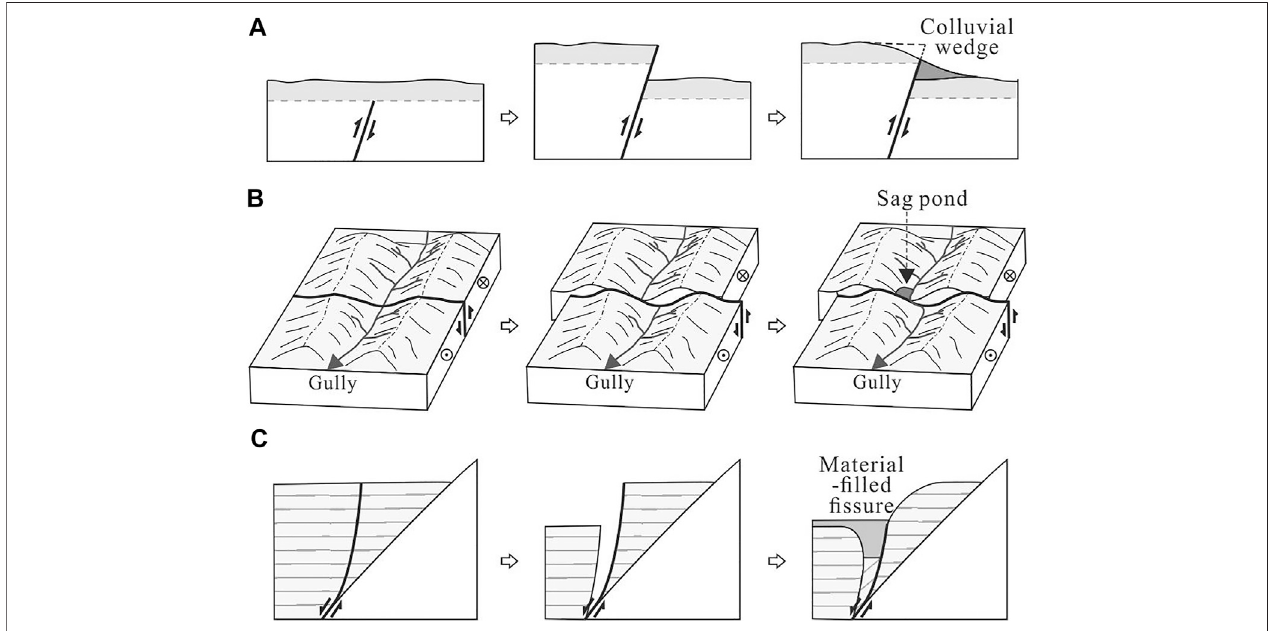
FIGURE 3 | High-quality event indicators and their formation: (A) colluvial wedge, (B) sag pond sediment, and (C) material- fi lled fi ssure, modi fi ed from (Wallace, 1977; Sieh, 1978; Allen et al., 1991; Bonilla and Lienkaemper, 1991; Nelson, 1992; Fumal et al., 1993; McCalpin, 2005). (A) As the fault moves, a fault scarp forms with the appearance of a free face. During the modi fi cation of the free face, until the slope of the fault scarp reaches the repose angle, the hanging wall will be eroded and will provide colluvial debris that accumulates along the degrading scarp as a colluvial wedge on the local footwall. (B) In the valley, a gully fl ows through the fault. The gully and the mountain on either side will be left-lateral offset by faulting during an earthquake. The gully is locally obstructed by the dislocated mountain of the footwall, andasagpondformsinwhichthe fi ne-graineddepositsrecordthisearthquake. (C) Anormalfaultbranchdevelopsinthemiddleofastratigraphicunit.Theunitwouldbe vertically displaced and horizontally separated to open a coseismic fi ssure as the fault shakes. Assuming that both sides of the fi ssure are eroded soon after the earthquake, this fi ssure would be fi lled with texturally distinct material and then the younger material.